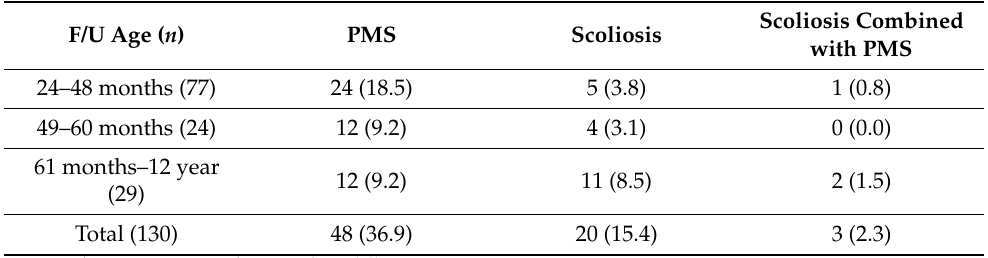
Table 3. Changes in the spine and pelvic alignment according to the ages at follow-up